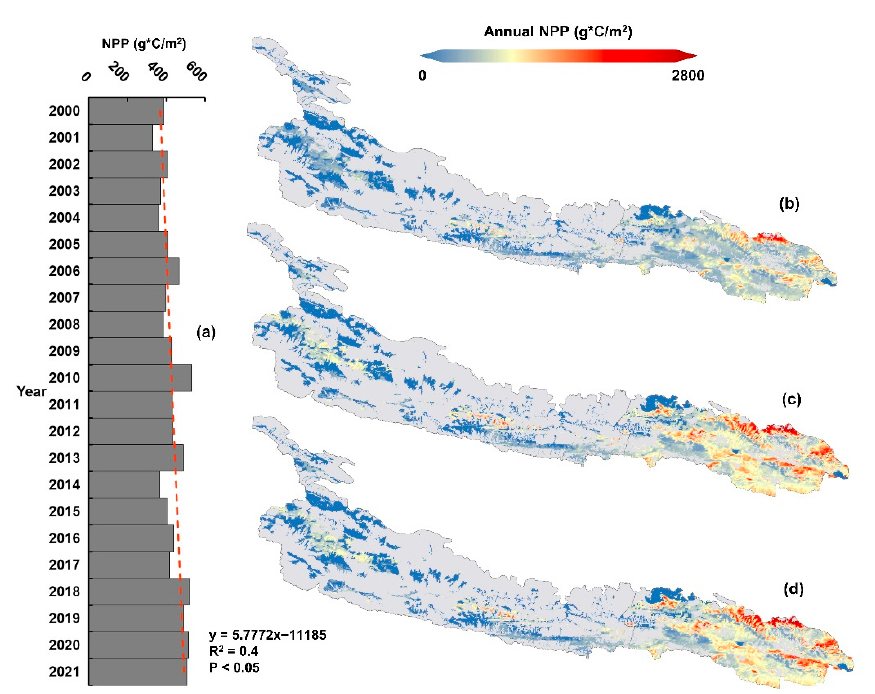
Figure 3. Annual average NPP of the vegetation area over the study area from 2000 to 2021 ( a ) and NPP spatial distributions in 2000 ( b ); 2010 ( c ) and 2020 ( d ). NPP is net primary productivity.